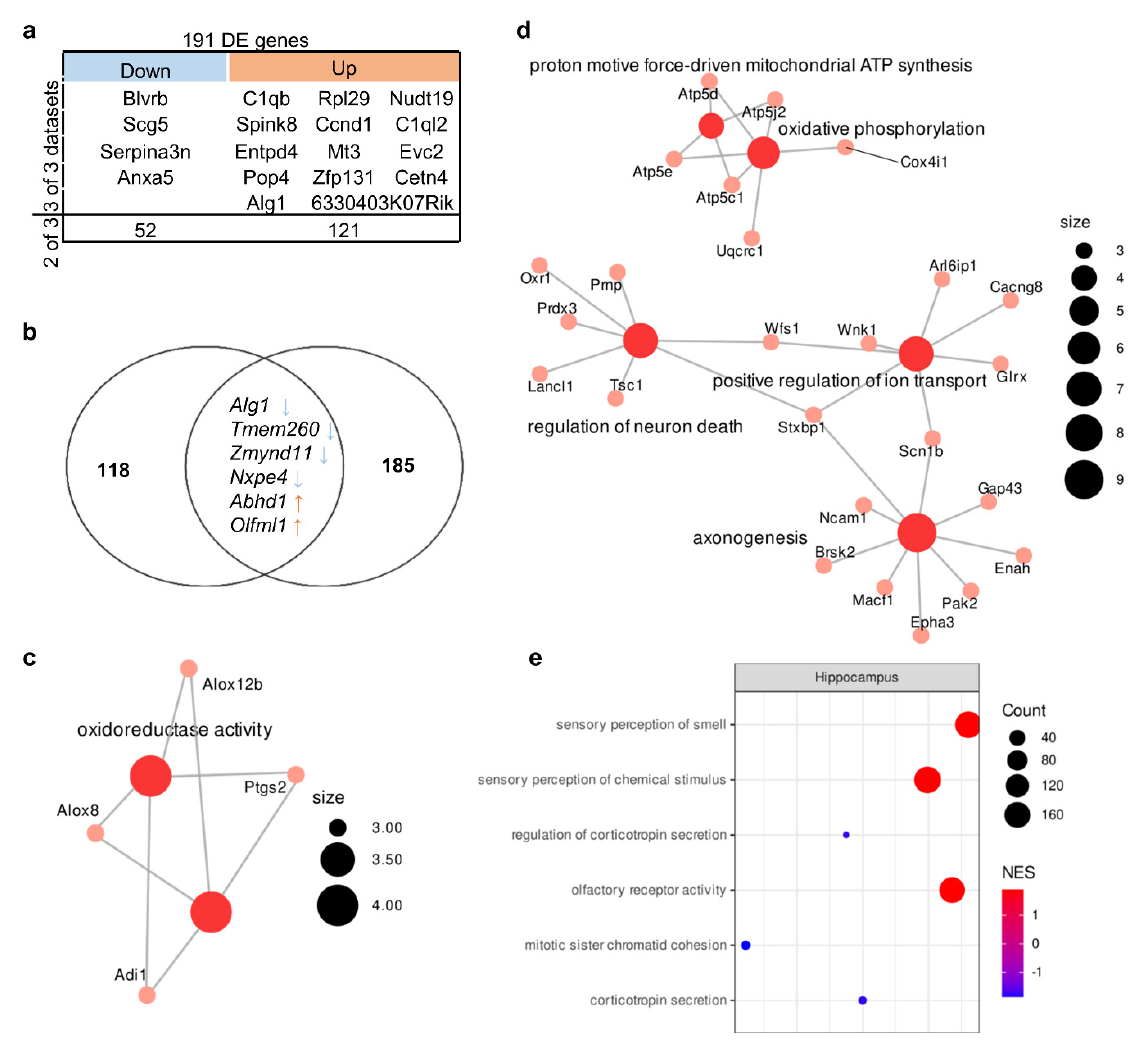
Figure 2. Molecular signatures in the hippocampus of BTBR mice. ( a ) Reproducible up- and down- regulated genes in the hippocampus. Out of a total of 191 DE genes, 4 were downregulated in all 3 datasets, and 52 were downregulated in 2 out of 3; 14 were upregulated in all 3 datasets, and 121 were upregulated in 2 out of 3. ( b ) The overlap between the set of genes carrying a “ high prediction score ” mutation and the set of DEGs. Out of 124 “ high prediction score ” genes only 6 overlapped with reproducible DE genes set (191 gene). ( c ) The GO category enriched in the set of DEGs. Size of the node represents number of genes in the category. ( d ) The GO categories enriched in the set of differentially expressed proteins according to data from ref. [40]. Size of the node represents number of genes in the category. ( e ) Top three up- and downregulated GSEA categories in the set of all expressed genes according to reanalysis of PRJNA533538 data. NES: normalized enrichment score. Size of the circle (count) represents number of genes in the category, color of the circle represents normalized enrichment score ( NES ).